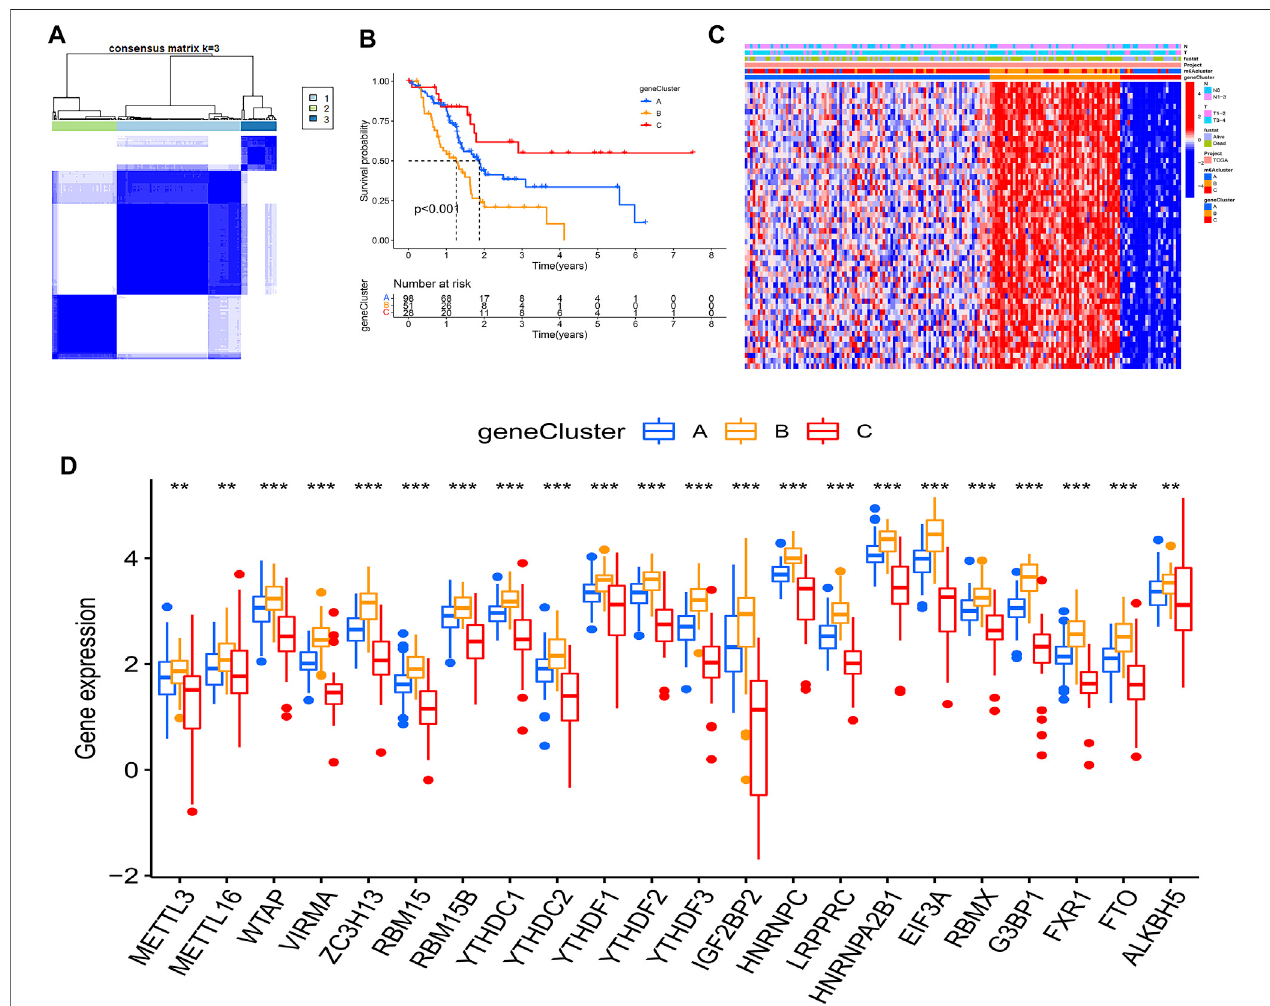
FIGURE 5 | Molecular characteristics of gene clusters. (A) Consensus clustering matrix for k (cid:1) 3; (B) KM analysis of patients in distinct gene clusters; (C) The heatmap depicted the expression levels of prognosis-related DEGs in distinct gene clusters; (D) Expression of m6A regulators between distinct gene clusters, the asterisks represented the statistical p value (* p < 0.05; ** p < 0.01; *** p <